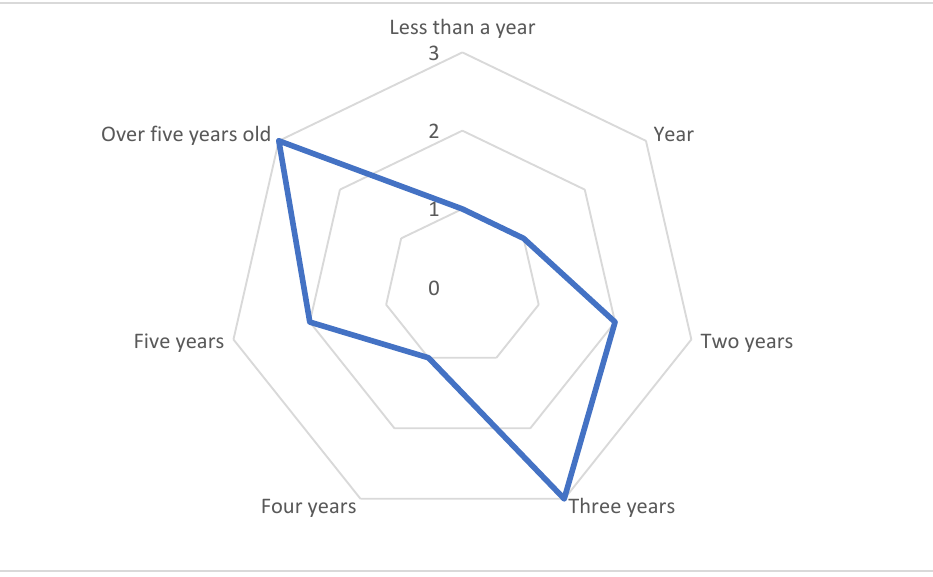
Figure 4. Time of functioning car-sharing systems on the market.